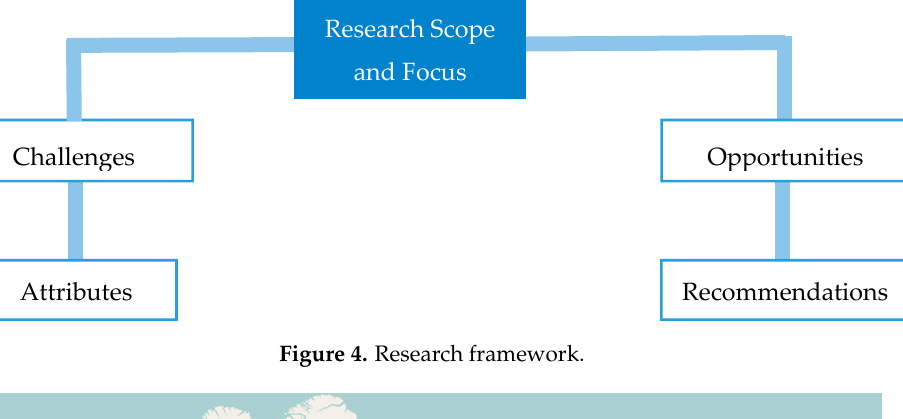
Figure 4. Research framework.